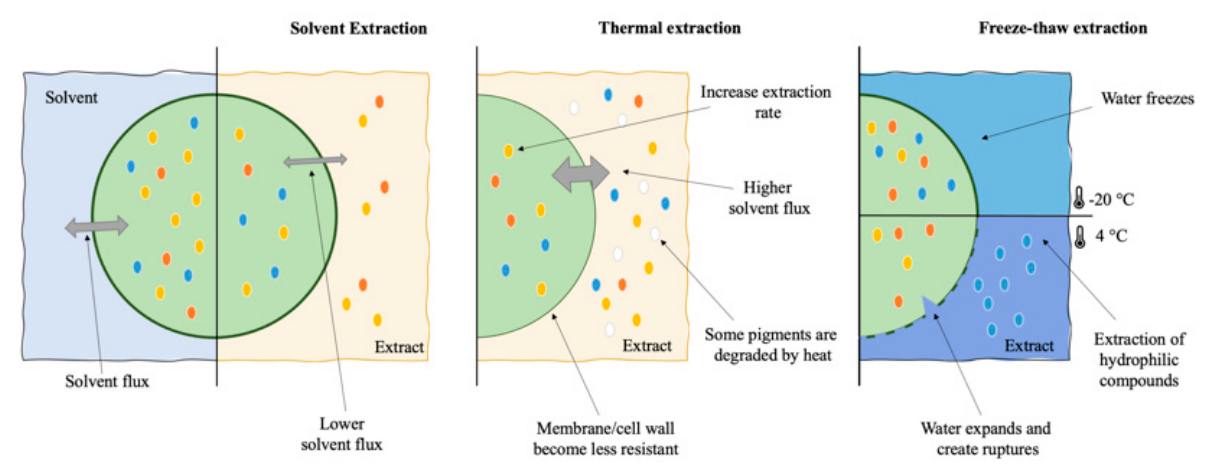
Figure 1. Diagram of classical extraction: solvent extraction, thermal extraction, and freeze − thaw extraction.